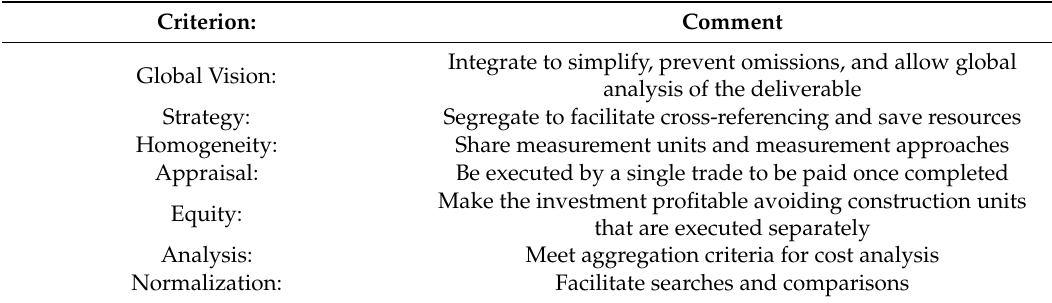
Table 2. Decomposition criteria to construction unit